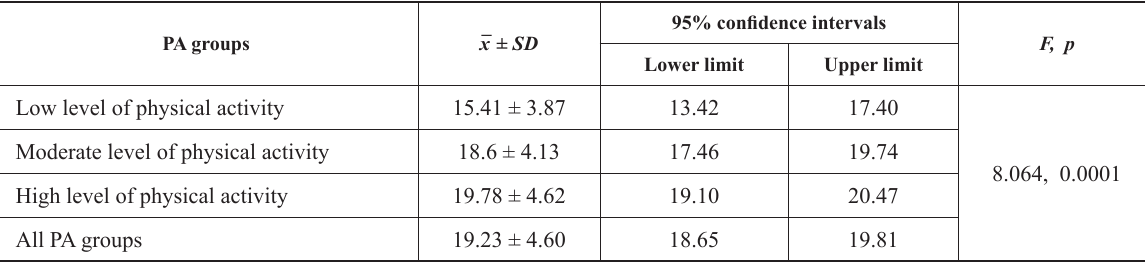
Table 9. Distribution of means of nerve tension and stress scores in groups of different physical activity